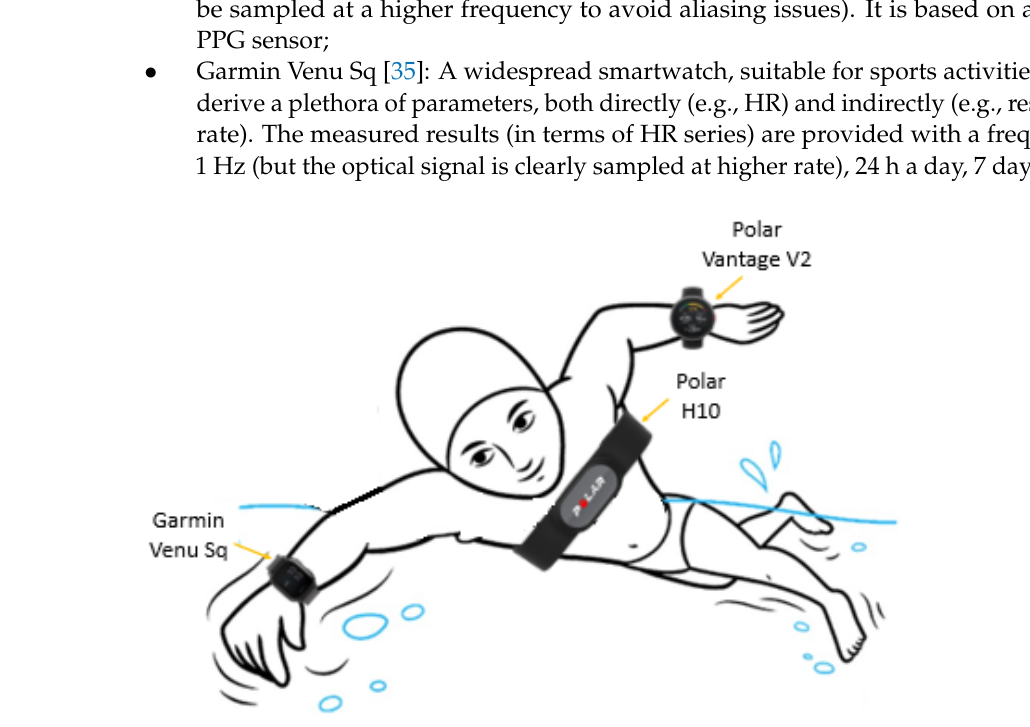
Figure 1. Device placement for in-water test: the two smartwatches are worn on the swimmer’s wrists (Polar Vantage V2 on the left wrist, Garmin Venu Sq on the right one), whereas the Polar H10 cardiac belt is on the thorax. The same devices were used for laboratory test acquisitions.